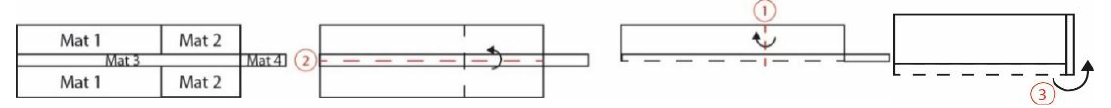
Figure 12. Sequence of crossfolding for method 2.